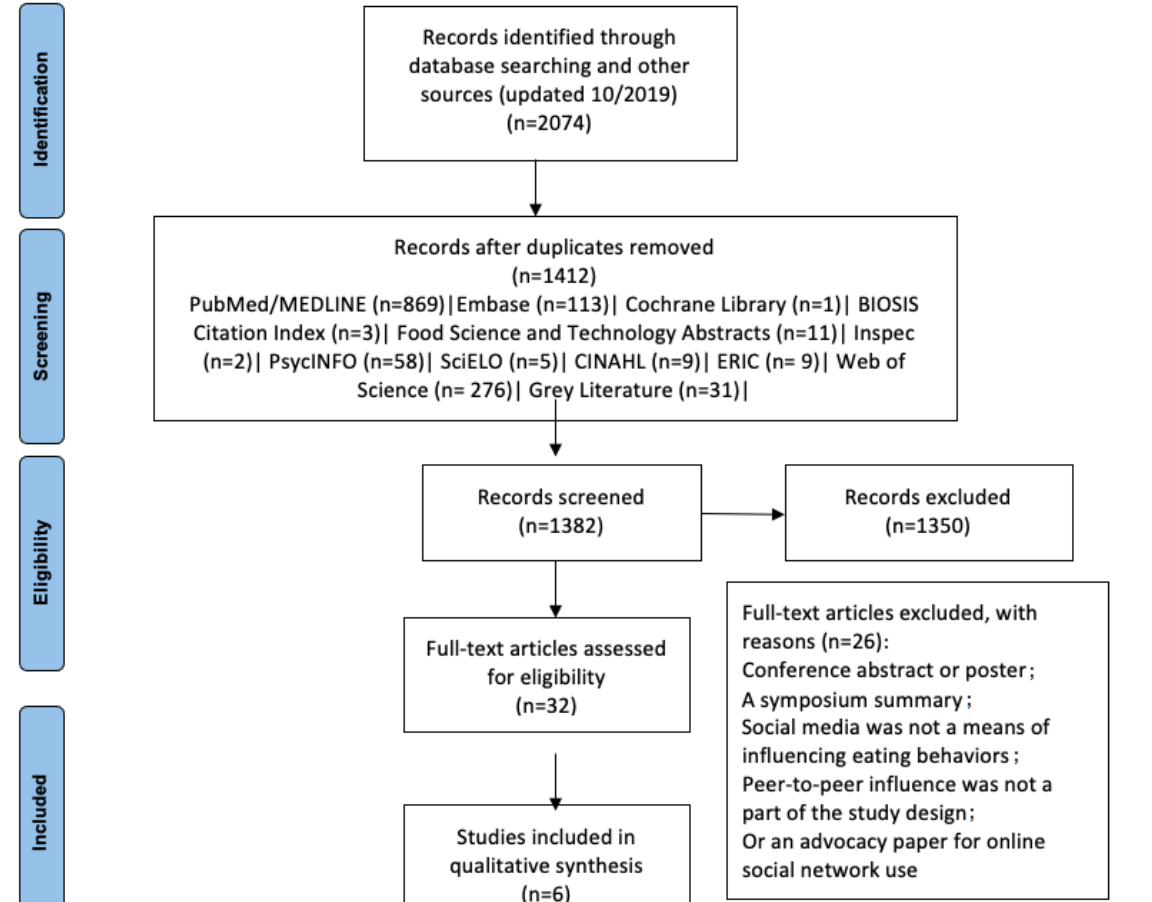
Figure 1. PRISMA (Preferred Reporting Items for Systematic Reviews and Meta-Analyses) flowchart for the articles that met the final inclusion process. Grey literature includes The New York Academy of Medicine Grey Literature Report and the OAIster database from the OCLC (Online Computer Library Center). ERIC: Education Resources Information Center; SciELO: Scientific Electronic Library